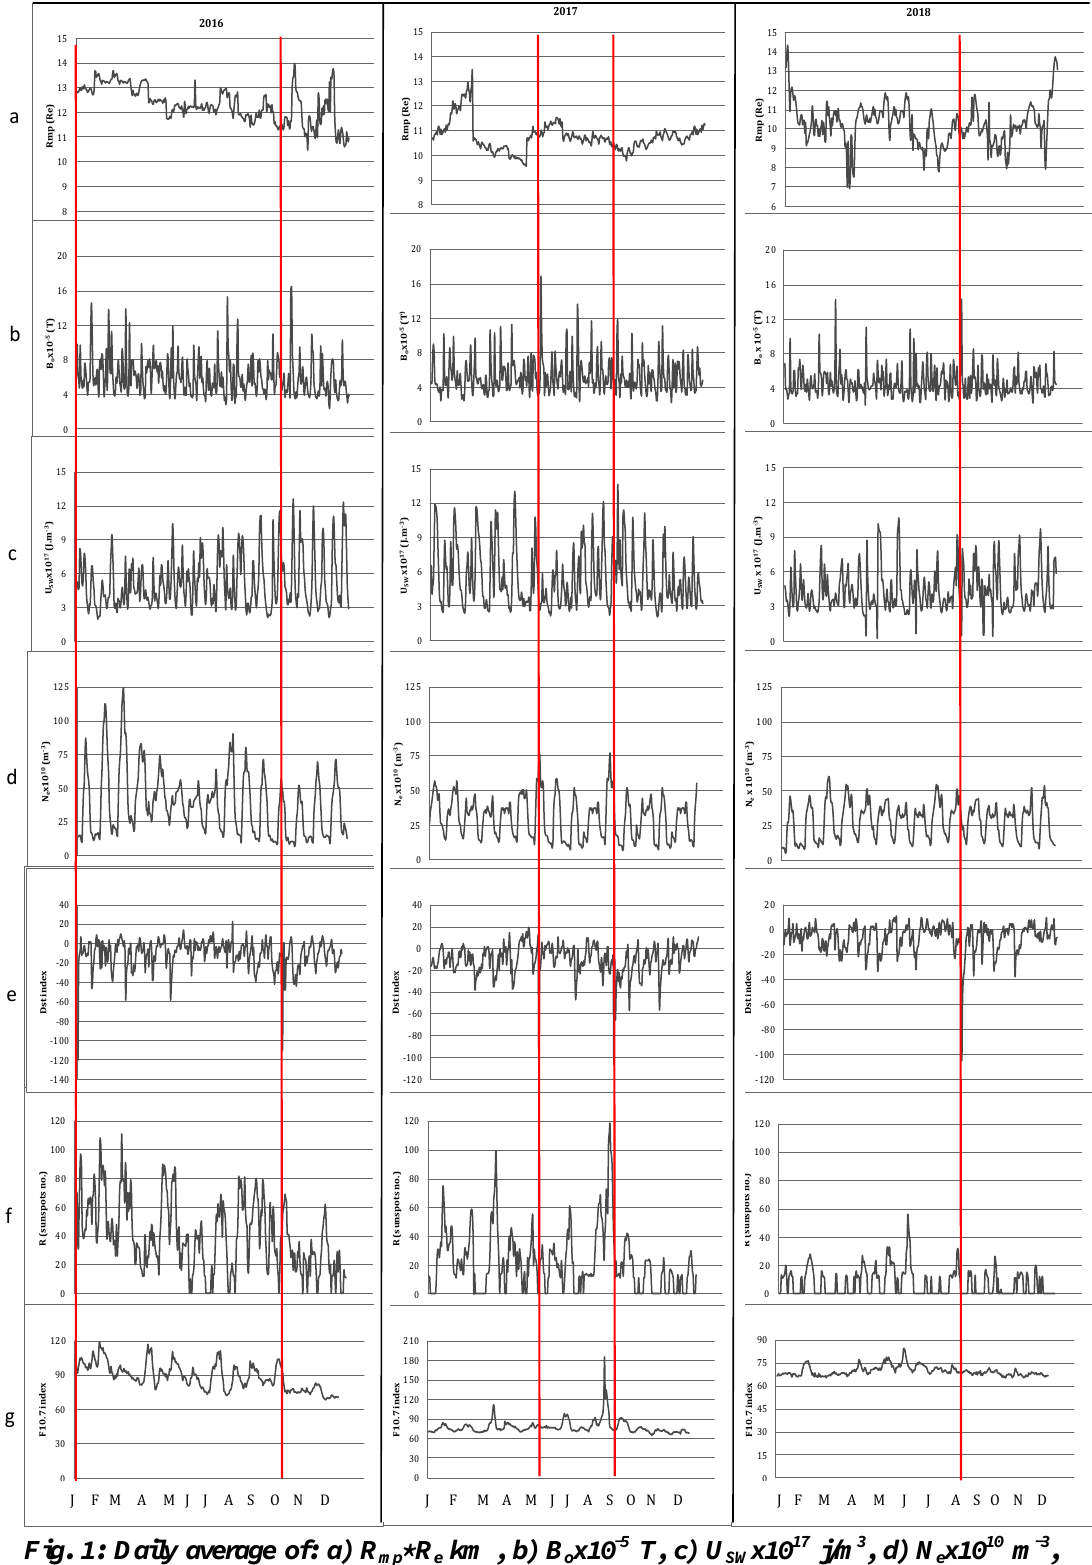
Fig. 1: Daily average of: a) R e) Dst index nT, f) Sunnspots no. (R) and g) F10.7 index for years